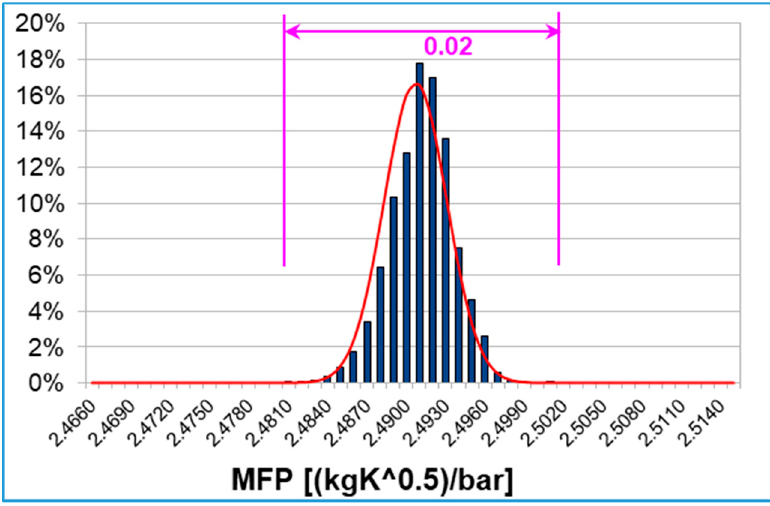
Figure 12. SB-UQ: mass flow parameter probability bars (blue) and related Gaussian trend (red line).